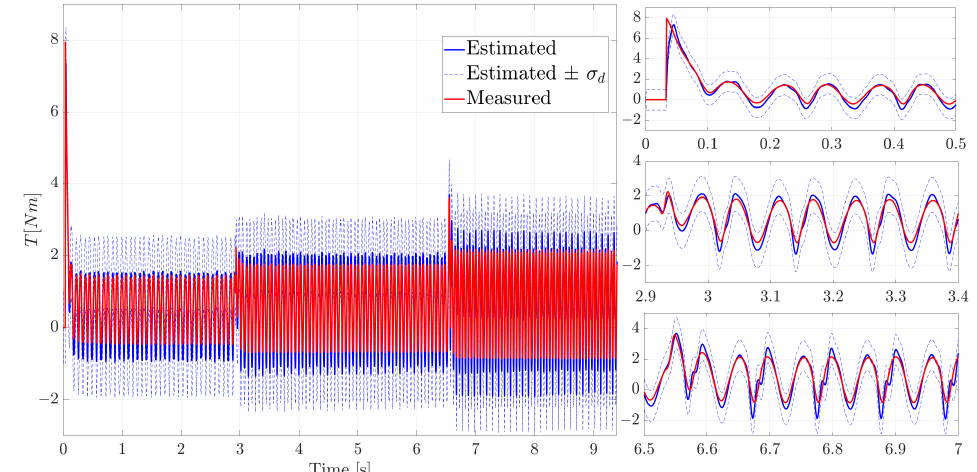
Figure 8. Comparison of the measured and estimated motor torque; on the left, full time series; on the right, the zoom-in on the velocity transitions are